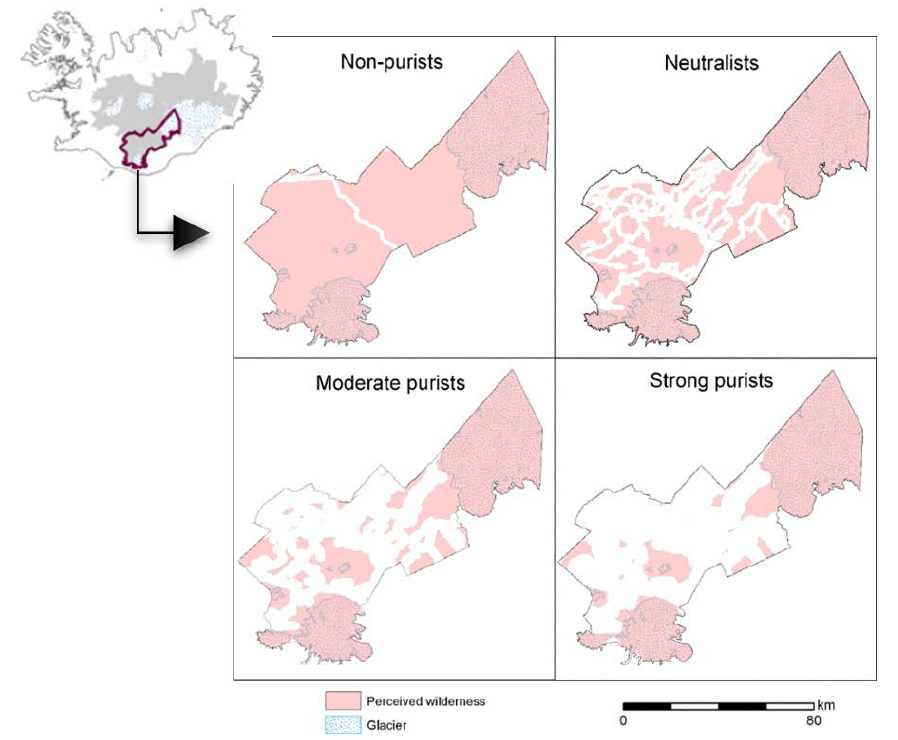
Figure 4. Tourists’ experience of wilderness in the Icelandic southern highlands [11].